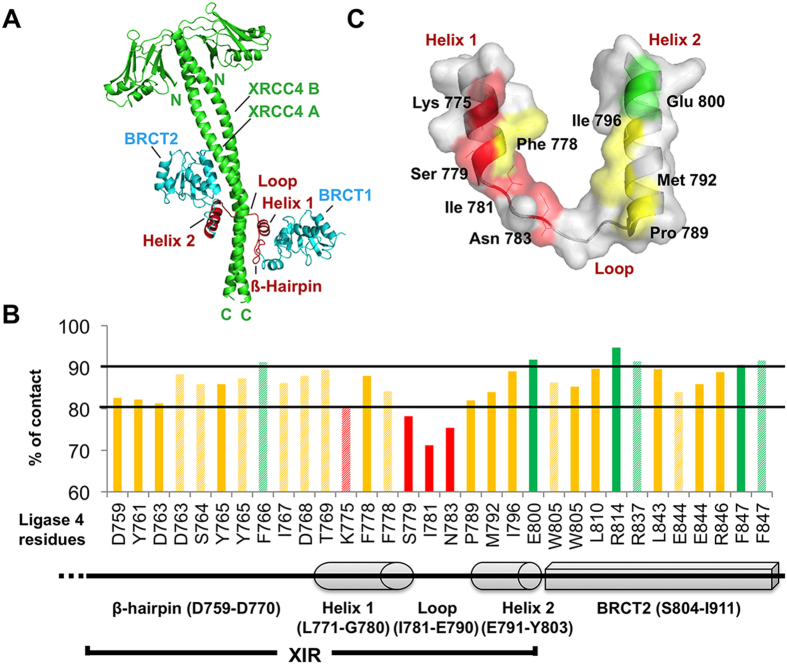
Structure of the human XRCC4/Lig4 complex and analysis of persistent contacts by Molecular Dynamics Simulation.(A) Crystal structure of the XRCC4/C-ter Lig4 complex (PDB entry 3II6) : the clamp domain (helix1-loop-helix2) is in red. (B) Distribution within the Lig4 C-ter domain of persistent contacts with XRCC4. Dashed and full boxes correspond to residues contacting XRCC4 A and B chains, respectively. Green, yellow and red colors highlight very persistent (contact >90%), persistent (80%< contact <90%) and poorly persistent (contact <80%) residues, respectively. (C) Cartoon and surface representation of residues within the Lig4 clamp domain according to persistent contacts with XRCC4. The colors correspond to residues as in B.